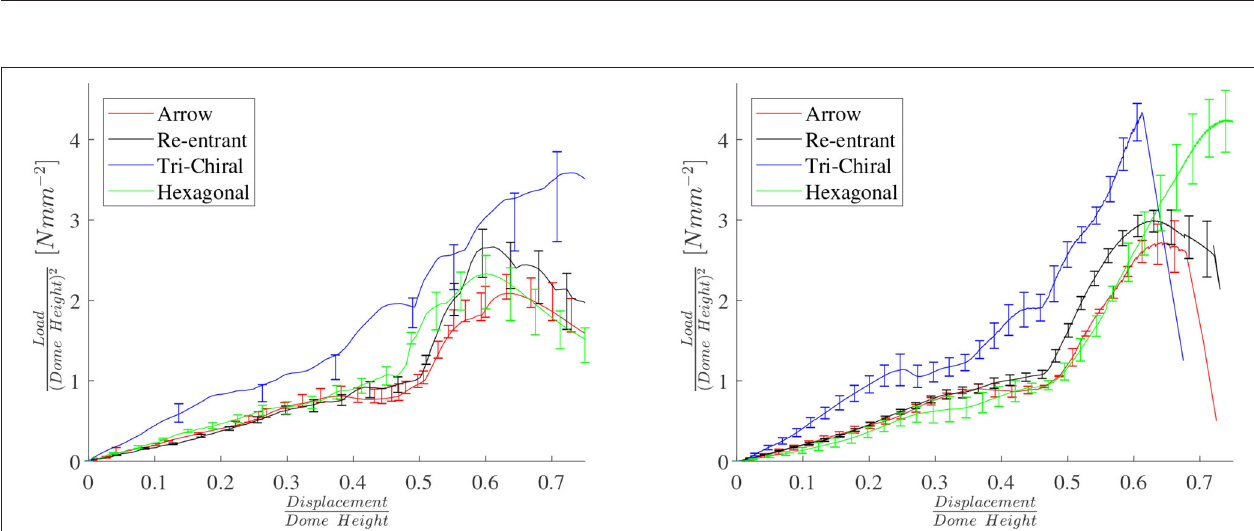
Frontiers in Materials |